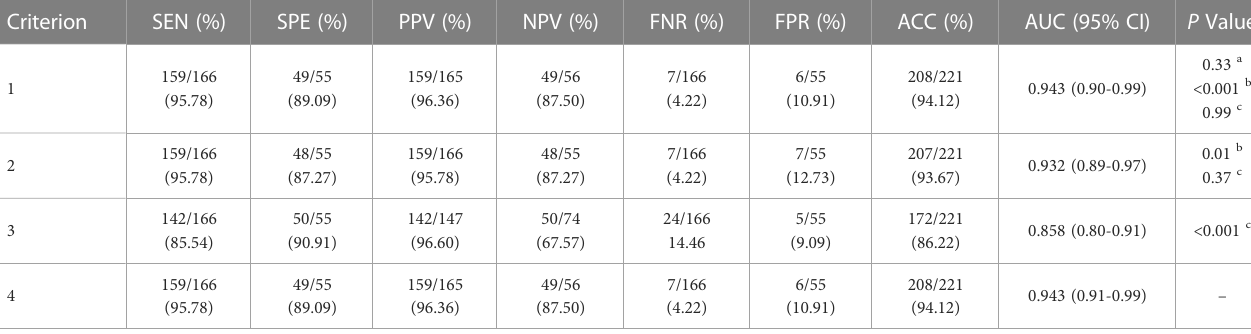
TABLE 1 Performance of AI-CADS in transverse and longitudinal planes for differentiating TNs. Criterion